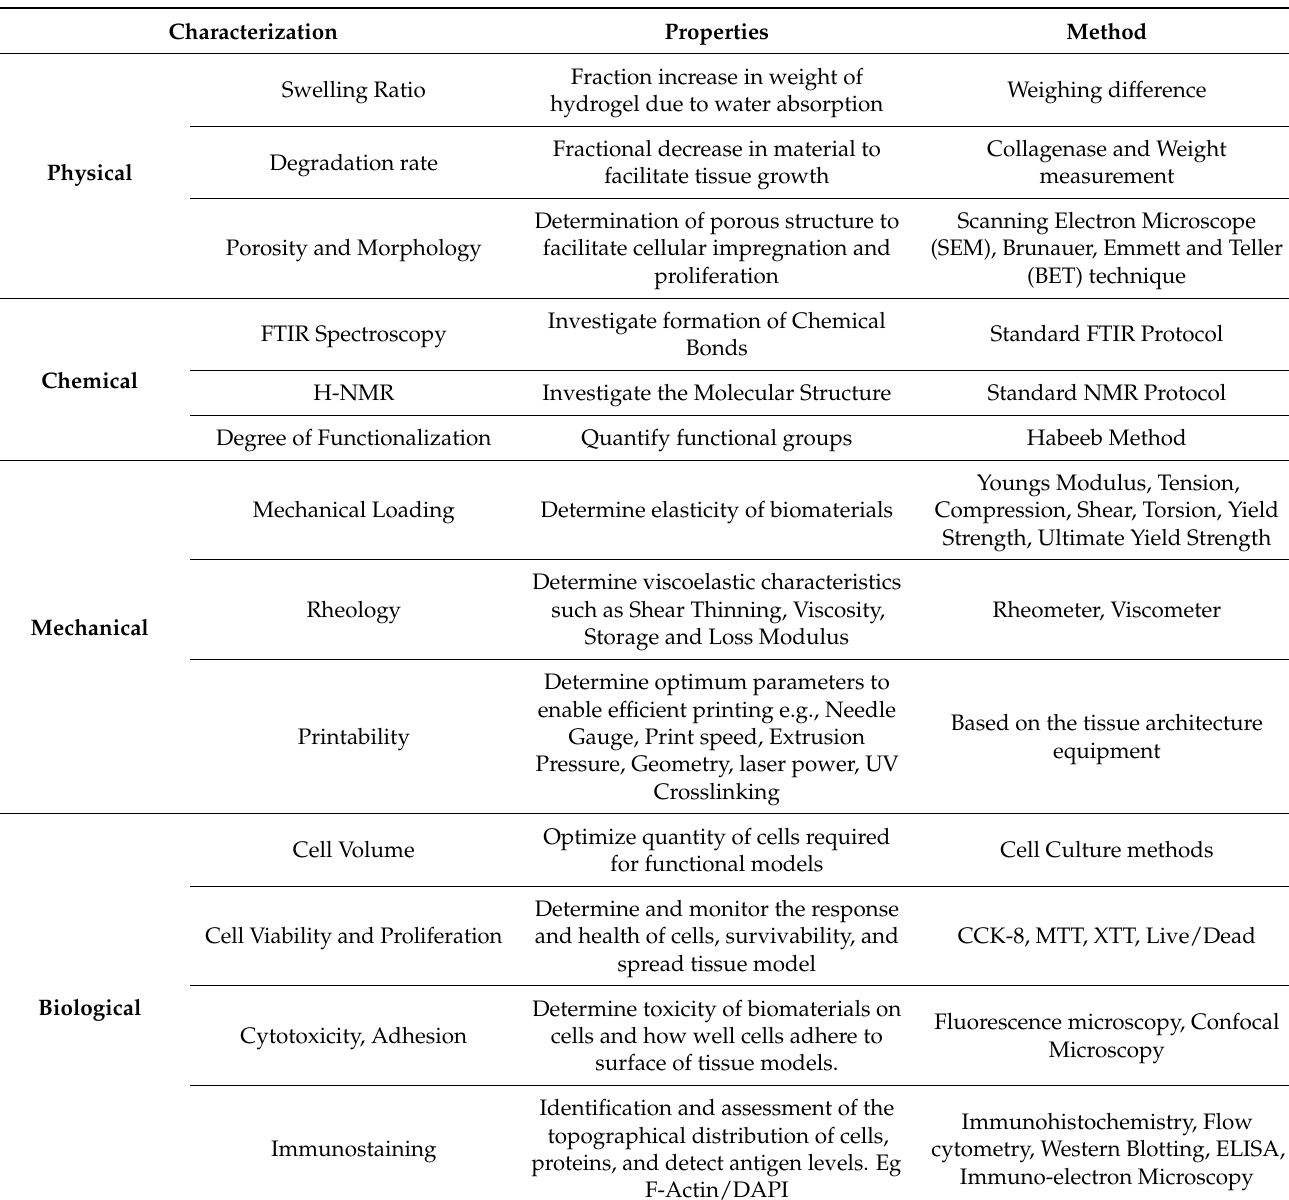
Table 4. List of quantitative methods utilized in the characterization of the fundamental properties of